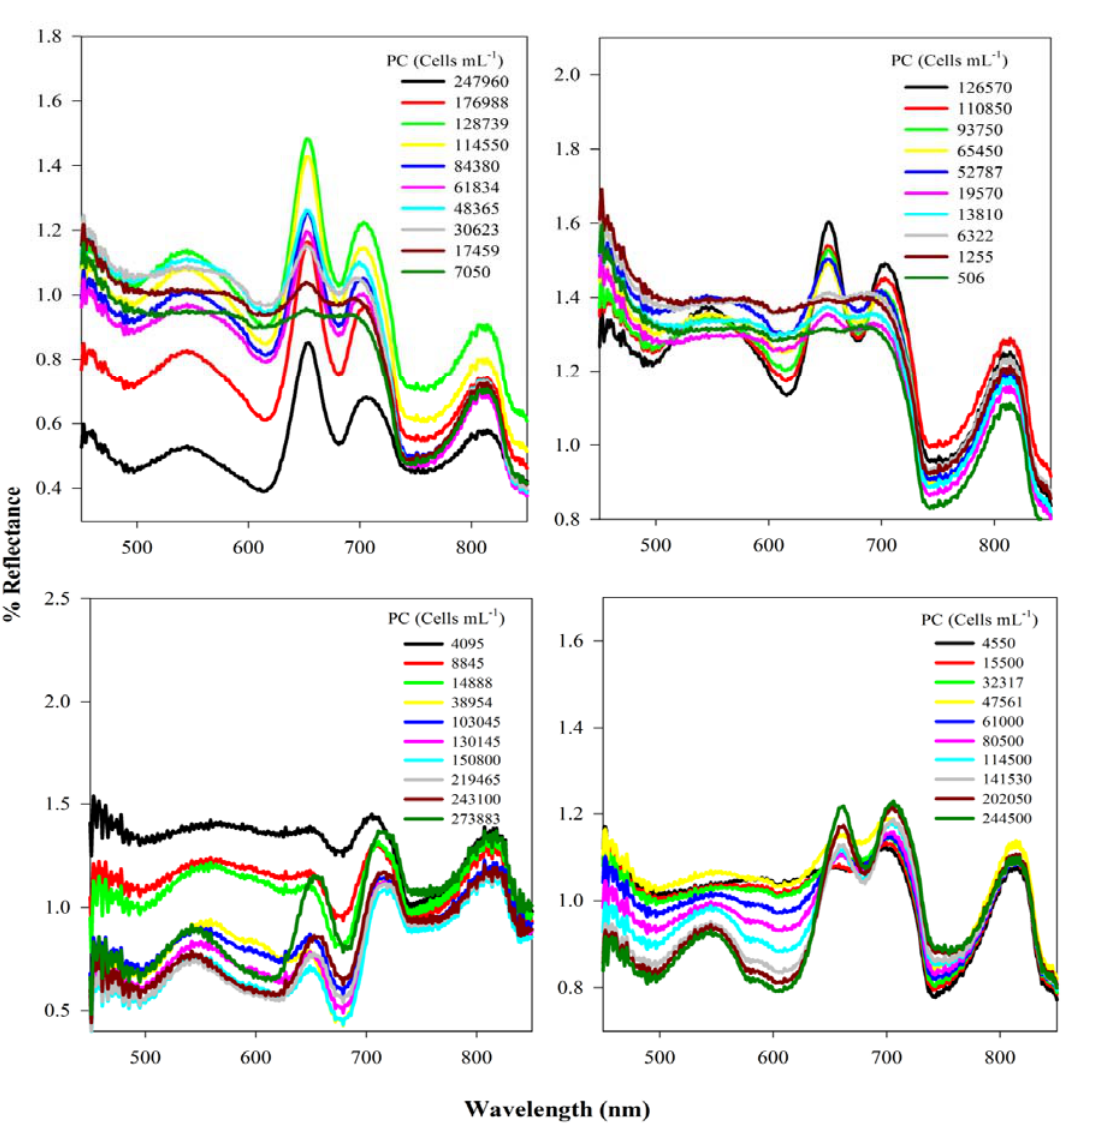
Figure 1. (A, B, C) Percent reflectance spectra of Synechocystis PCC 6803 from Exp I, II, III respectively. (D) Percent reflectance spectra of Anabaena from Exp